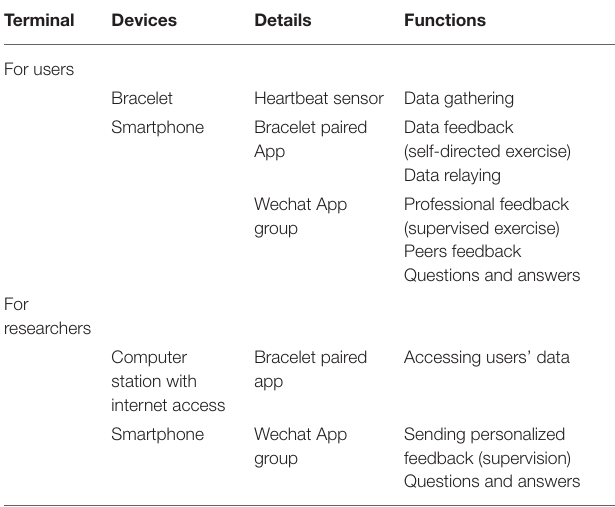
TABLE 1 | The structure and components of supervised mHealth